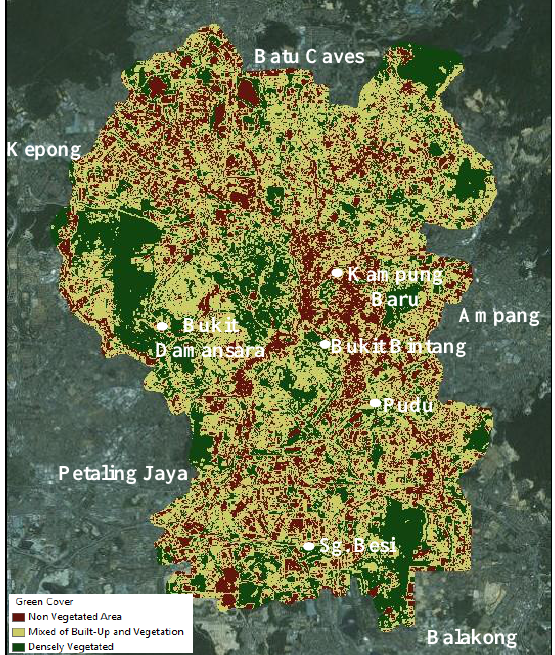
Figure 6. Distribution of green areas in Kuala Lumpur